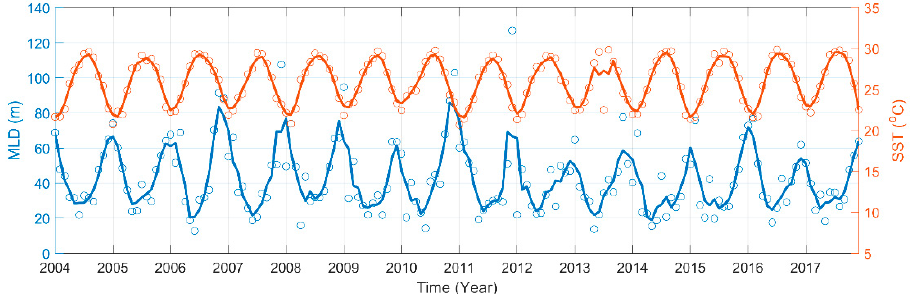
Figure 13. Time-series of average SST and MLD in the PRE from 2004 to 2017.